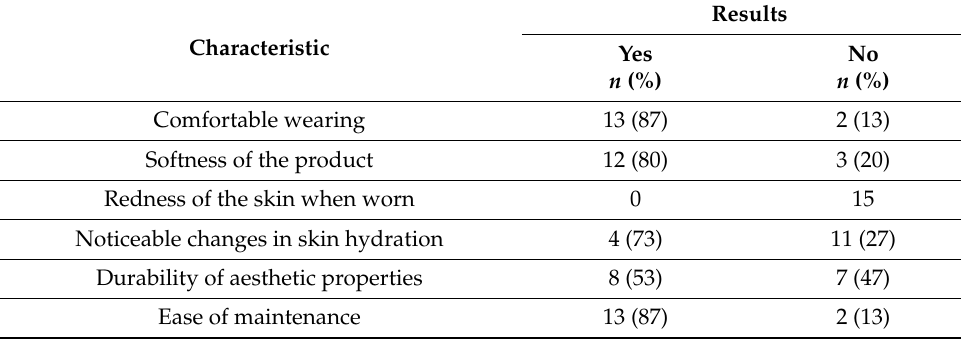
Table 9. Subjective assessment of the properties of clothing during use.